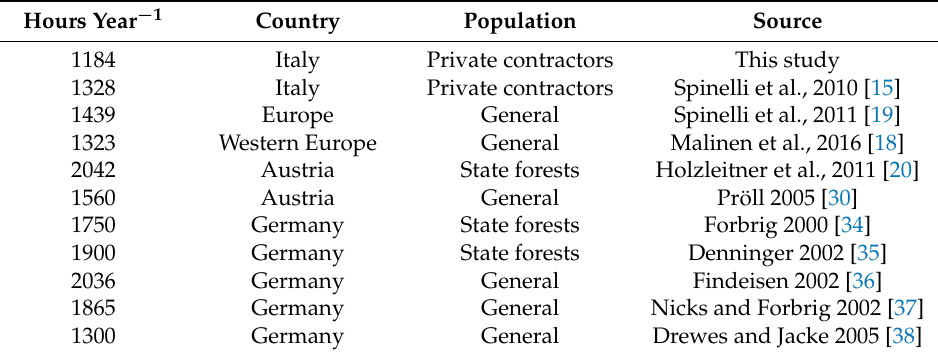
Table 5. Annual utilization of purpose-built harvesters in some European